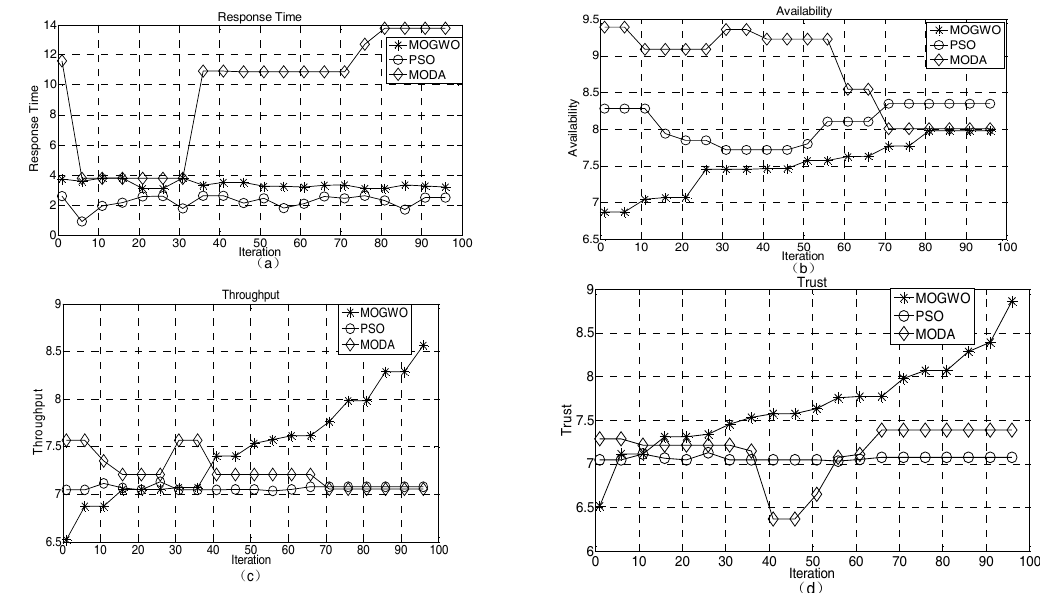
Figure 9. Comparison of the optimal value of a single index. ( a ) response time; ( b ) availability; ( c ) throughput; ( d ) trust.